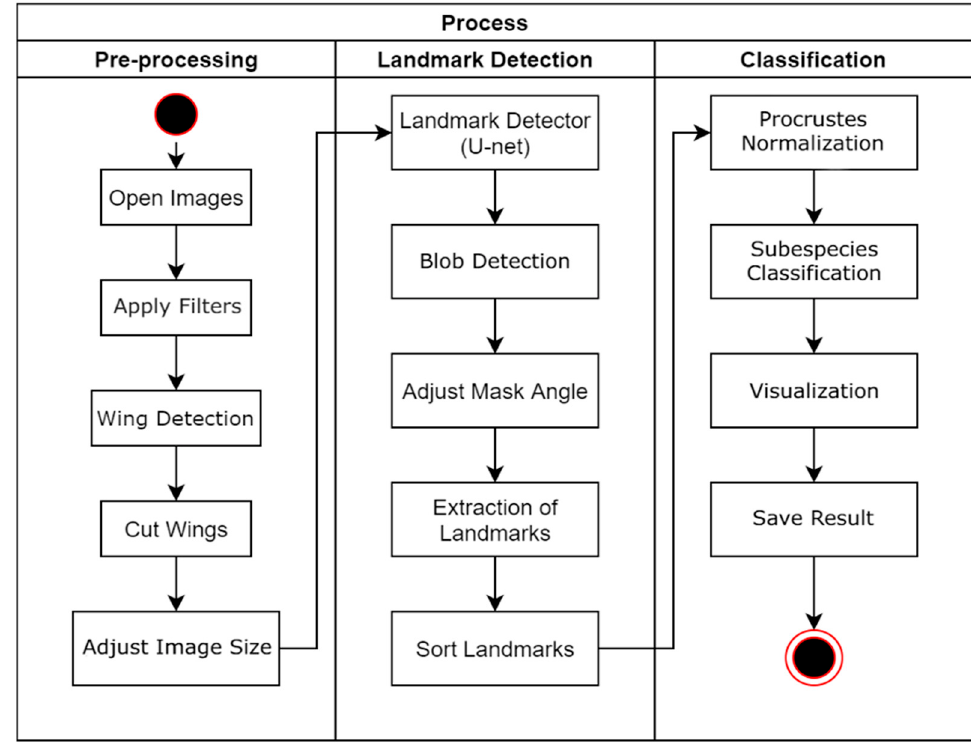
Figure 6. Pipeline developed for the processing of forewing images for honey bee classification.